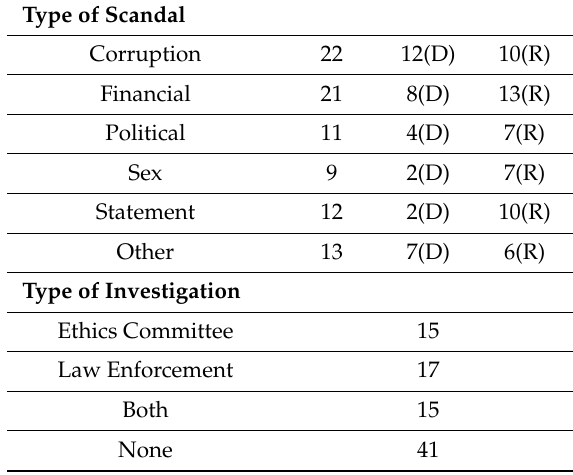
Table 1. Characteristics of incumbent scandals, 1972–2016. D—Democrat;